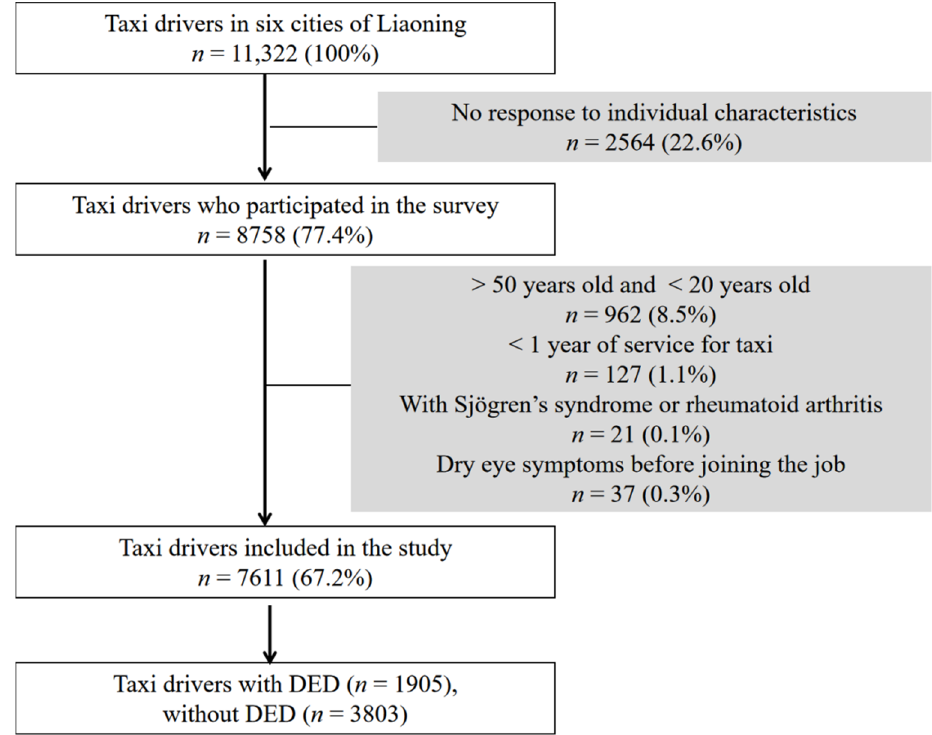
Figure 1. The flow chart of cases and controls selection.